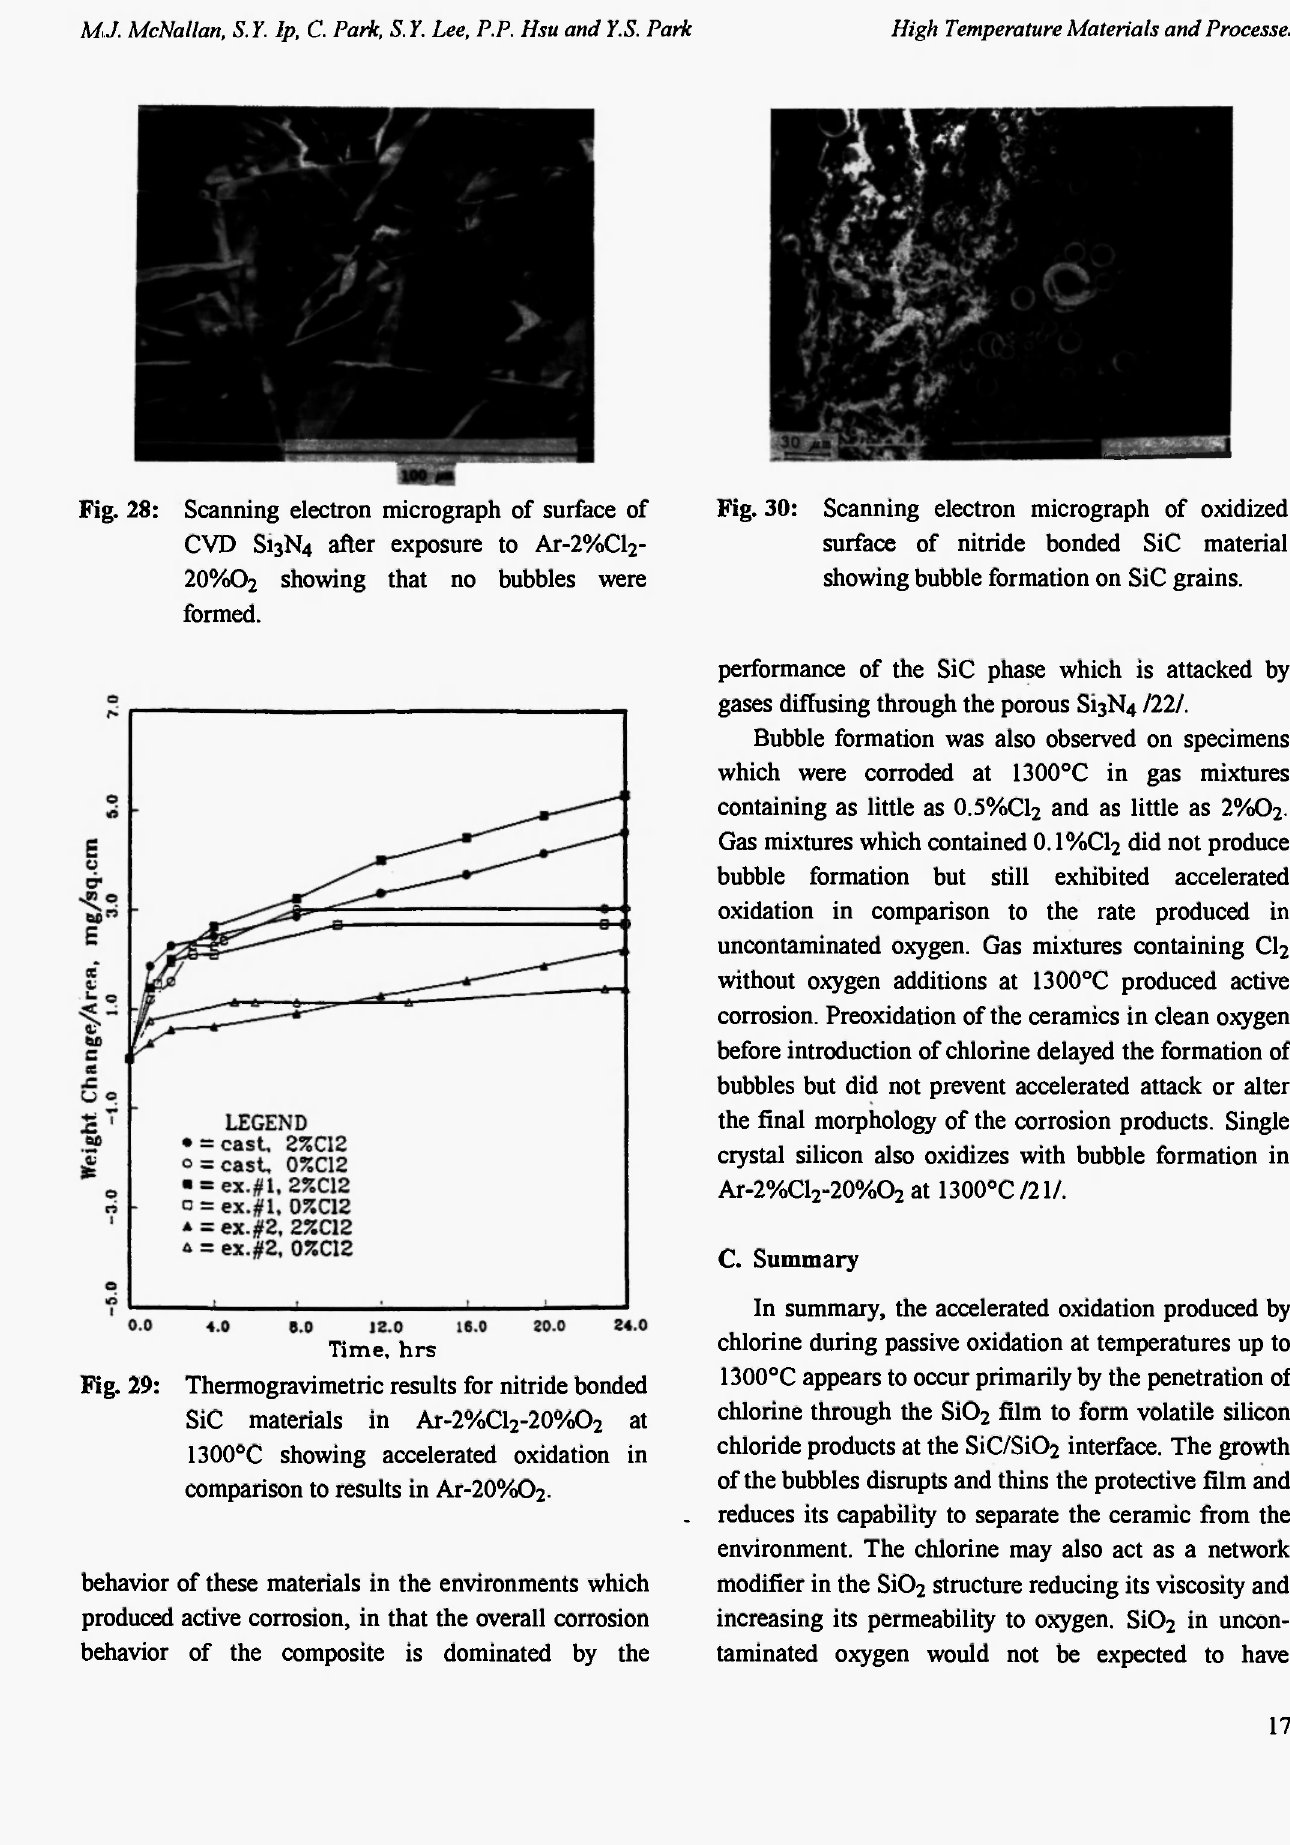
Fig. 30: Scanning electron micrograph of oxidized surface of nitride bonded SiC material - 2 showing bubble formation on SiC